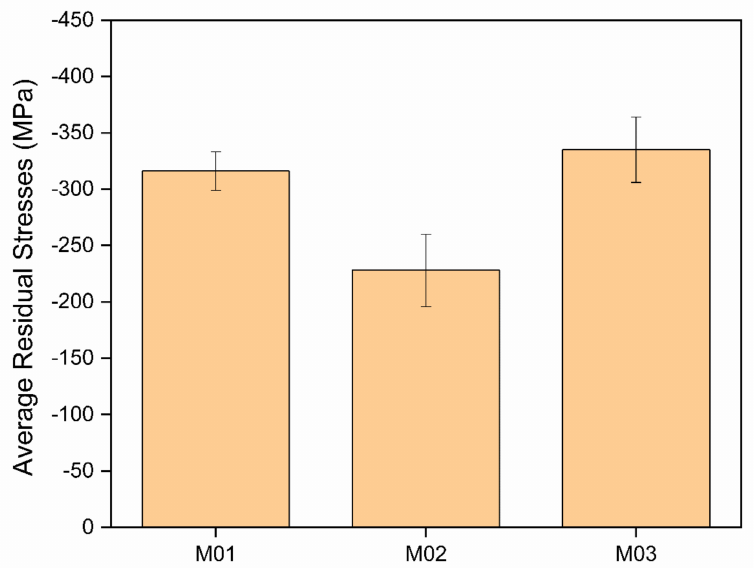
Figure 6. The residual stresses in the CrN/CrAlN multilayers deposited onto the gas-nitrided diesel piston rings as a function of the sputtering